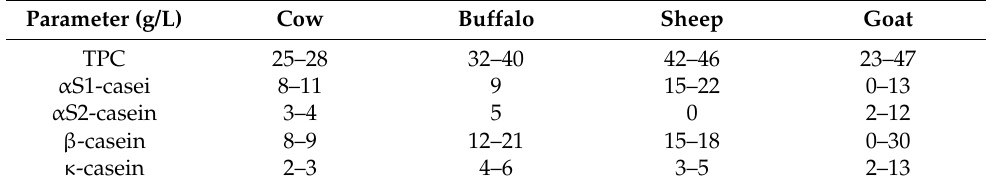
Table 5. Casein fraction in cow, buffalo, goat, and sheep milk. Abbreviation: TPC = total protein content